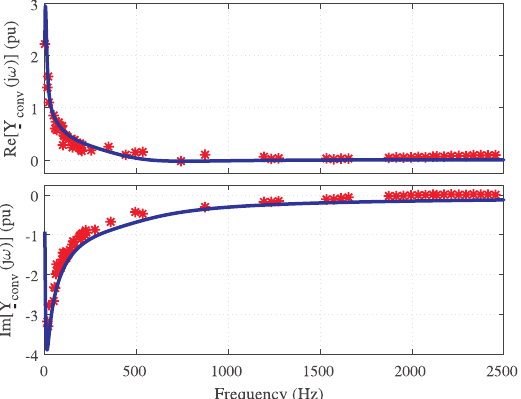
Figure 8. Input admittance for the analytical model (blue) and experiment (red); parameters: T samp = T cont = 0.2 ms, bandwidth of the power controllers 3 Hz, power-measurement filter 30 Hz, current controller 300 Hz, voltage feedforward filter 30 Hz, and R v = R f , L v = L f